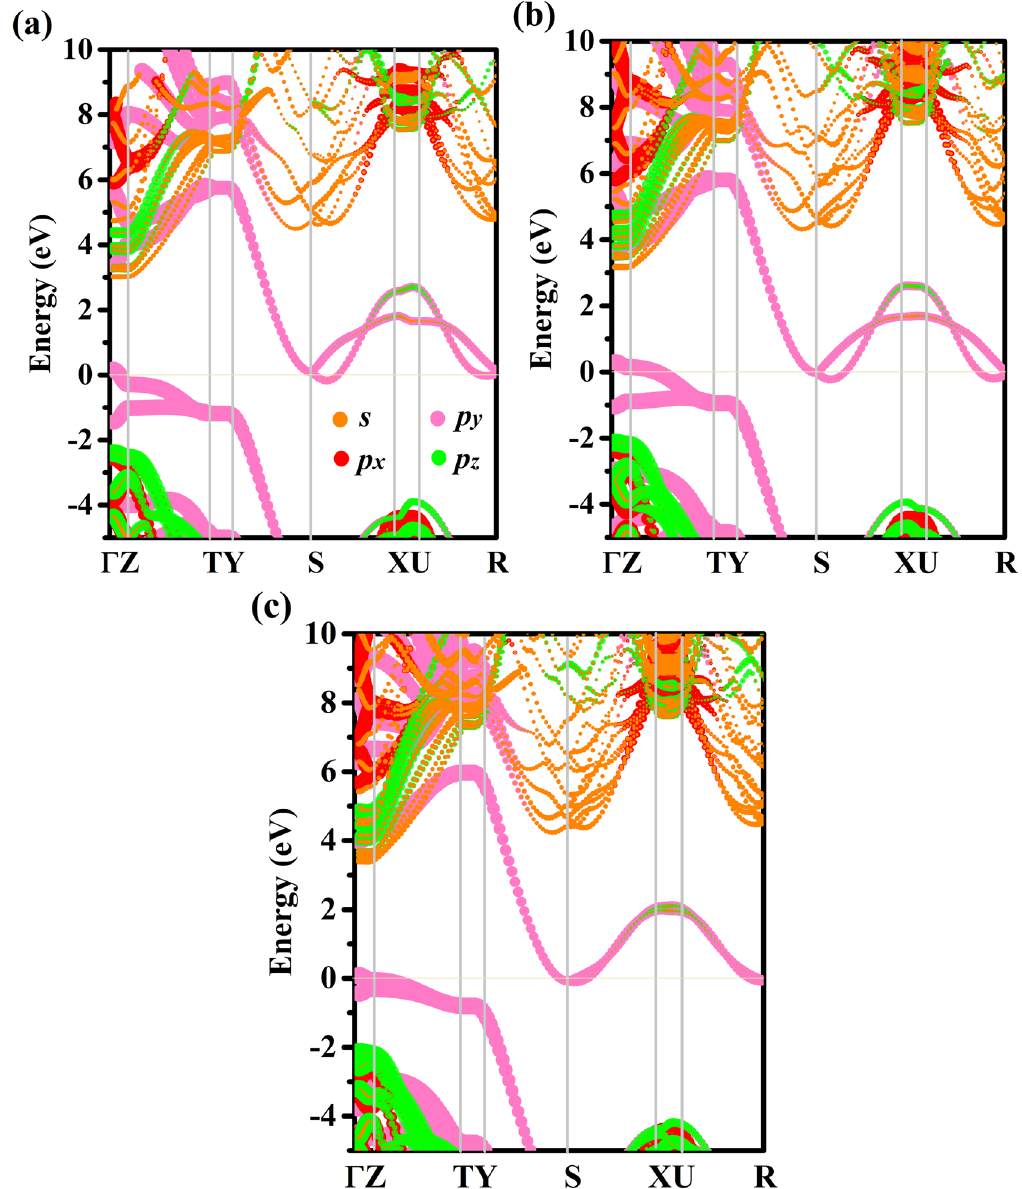
Figure 3: Band structures of o P - C 16 ( a ) , o P - C 20 ( b ) , and o P - C 24 ( c )